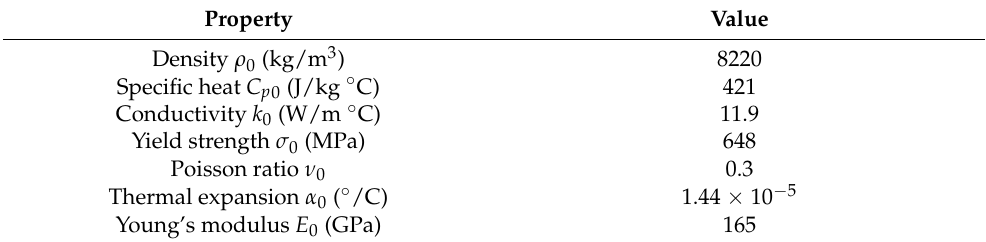
Table 1. IN718 physical, mechanical, and thermal material properties at room temperature ( T 0 ) [33].